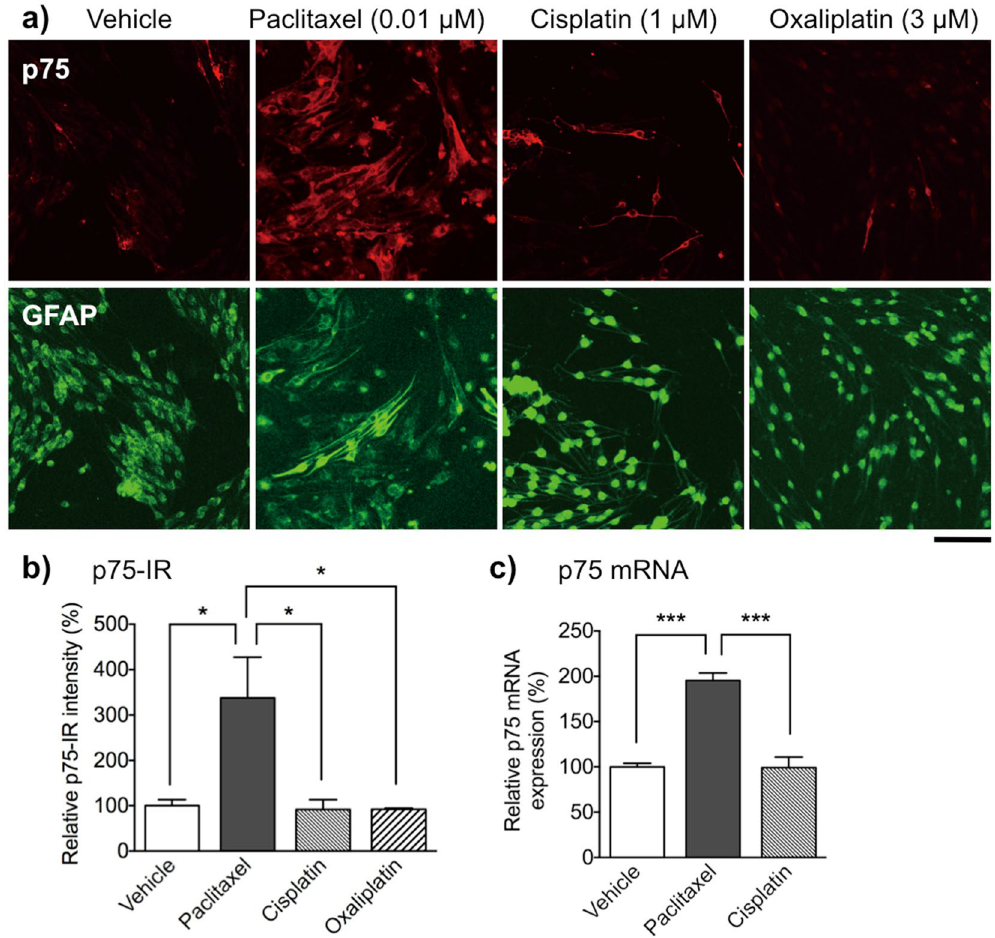
Figure 6. Effect of paclitaxel, cisplatin and oxaliplatin on expression of p75 in primary cultured Schwann cells. Schwann cells were treated with vehicle (0.1% DMSO), paclitaxel (0.01 μ M), cisplatin (1 μ M) or oxaliplatin (3 μ M) for 48 h. ( a ) Immunofluorescent staining of primary cultured Schwann cells for p75 (red) and GFAP (green). Scale bar: 100 μ m. ( b ) p75-IR in Schwann cells. Each column represents the mean ± S.E.M. n = 3. *** p < 0.001 vs . the vehicle-treated group. Only weak p75-IR was observed in GFAP-positive Schwann cells after treatment with vehicle, cisplatin, or oxaliplatin, whereas paclitaxel increased p75-IR in GFAP-positive Schwann cells. ( c ) Quantitative real-time PCR analysis of p75 mRNA expression in Schwann cells. Each column represents the mean ± S.E.M. n = 3. *** p < 0.001. Treatment with paclitaxel, but not cisplatin, led to a significantly increased in expression of p75